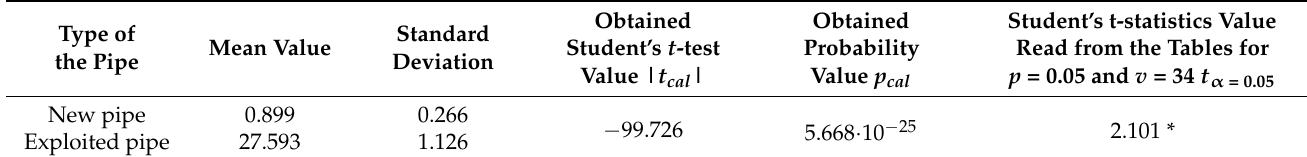
Table 5. Results of calculations of the Student’s t-statistics. The differences of average values are significant with probability p < 0.05.